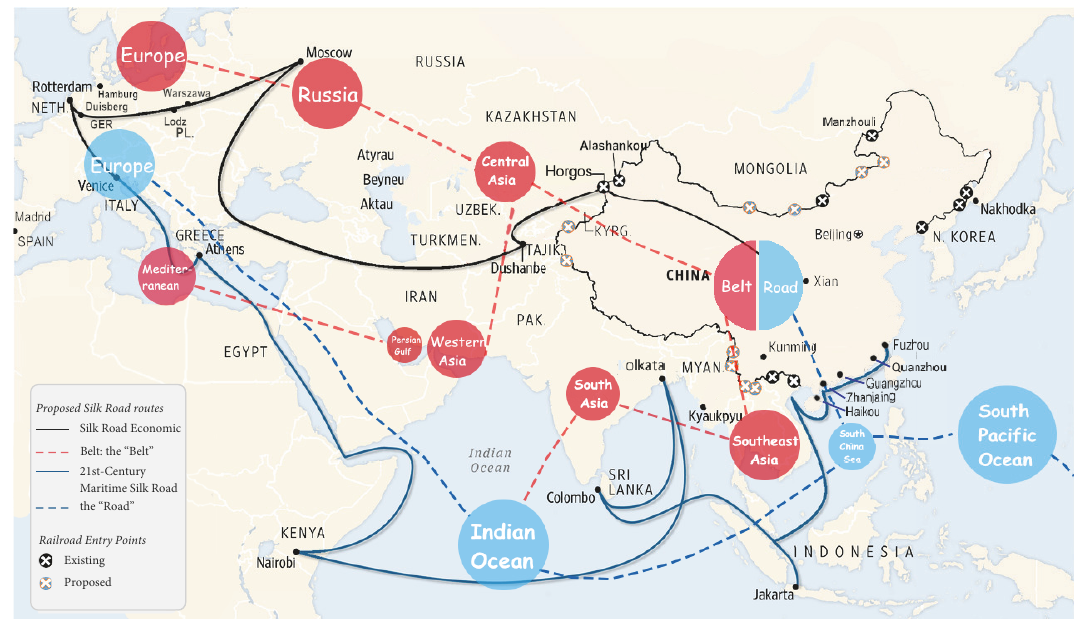
Figure 1: The Routes of “the Silk Road Economic Belt and the 21st Century Maritime Silk Road” (source: author, adapted